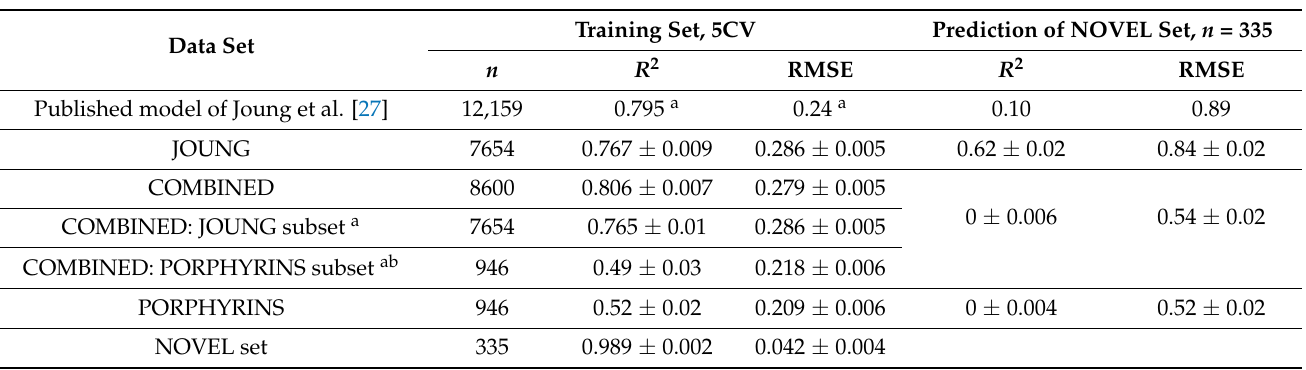
Table 2. Statistical parameters of models developed using different training sets for prediction of the extinction